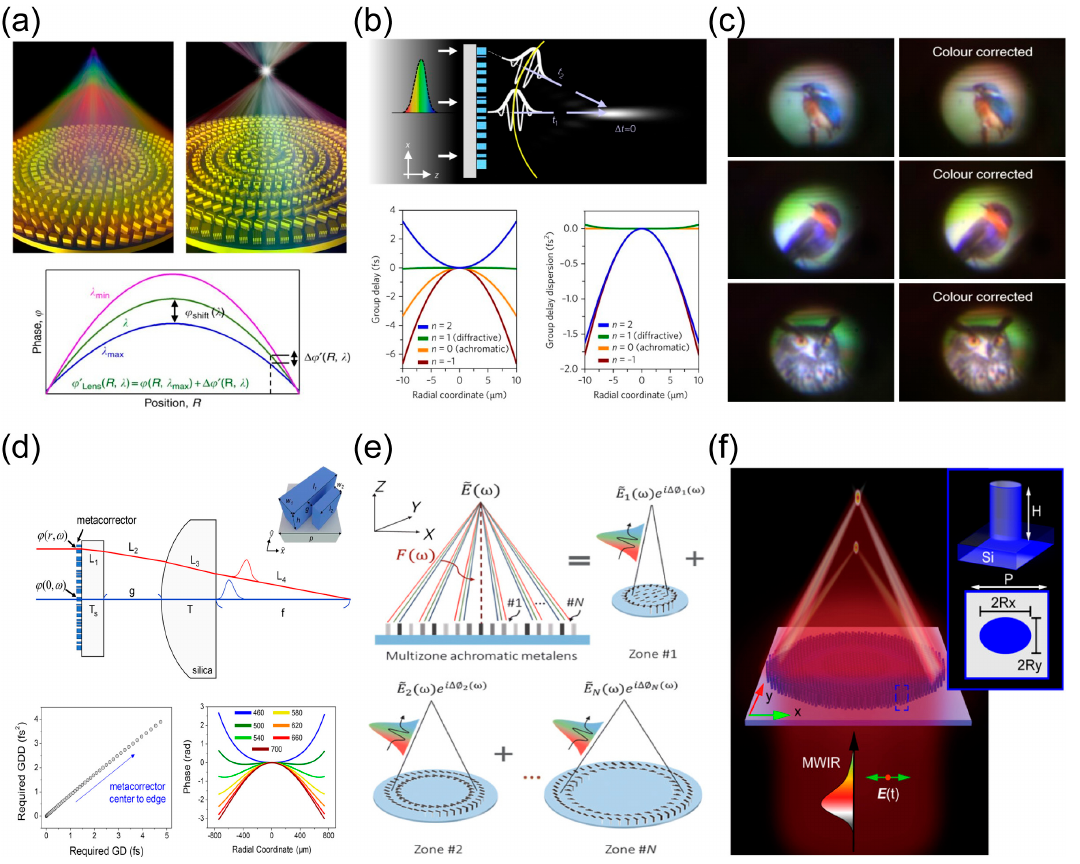
Figure 6. Broadband achromatic metalenses. ( a ) Schematics of comparison between chromatic (left) and achromatic (right) metalenses [50]. ( b ) Principle of broadband achromatic metalenses [181]. ( c ) Fullcolor imaging with (right) and without (left) an achromatic metalens [182]. ( d ) Schematic of hybrid metalens consisting of a meta-corrector with dispersion control and a commercial spherical lens [183]. ( e ) Principle of RGB-achromatic metalens with constructive interference and dispersion engineering [103]. ( f ) Schematic of varifocal achromatic metalens which can achromatically focus mid-wavelength infrared beams in different focal planes according to the incident polarization states